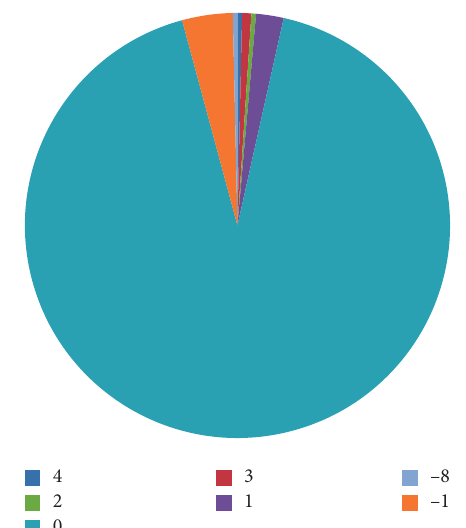
Figure 2: The distribution of net talent flows of